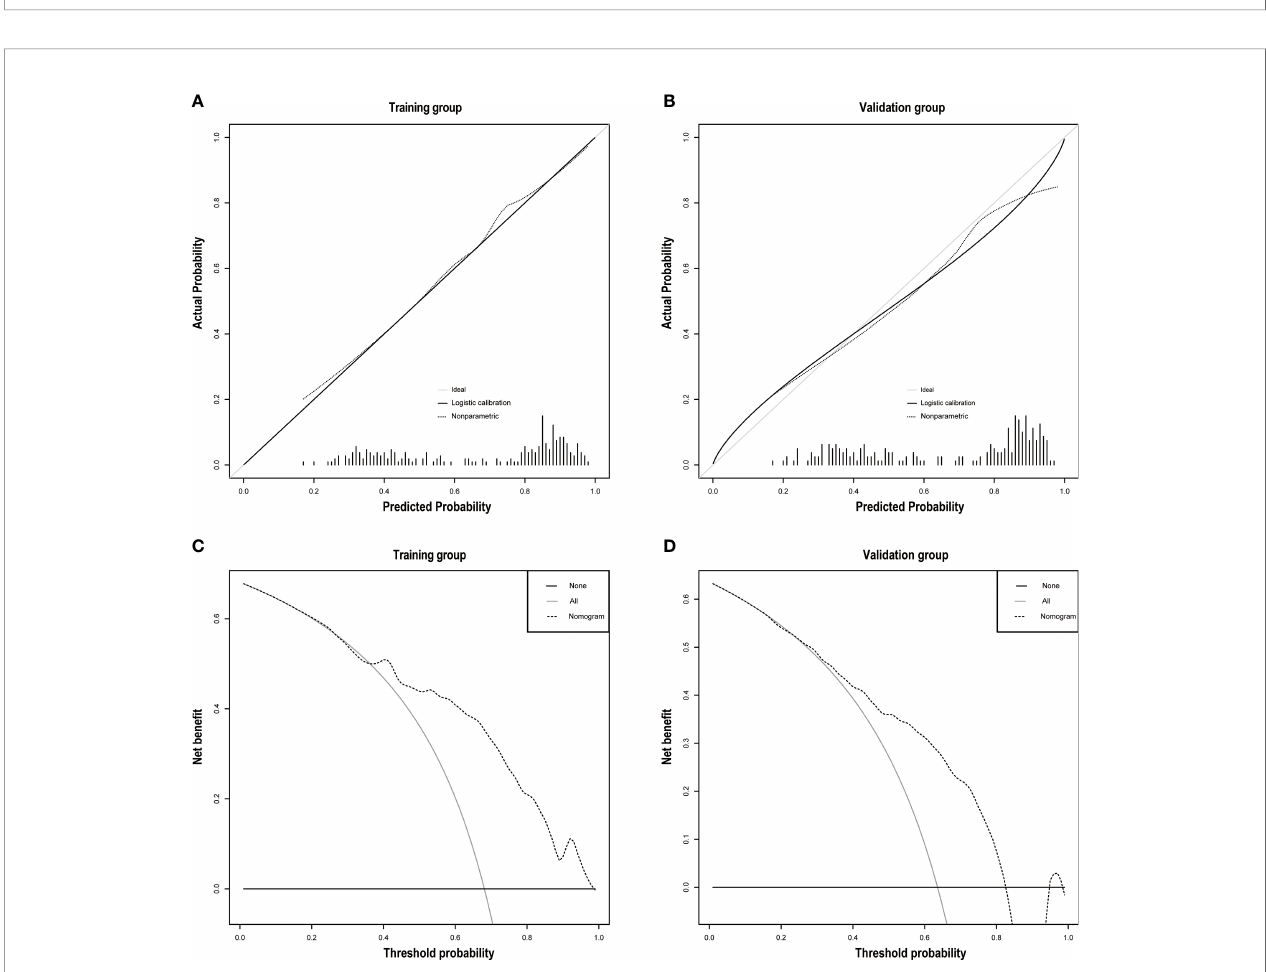
FIGURE 6 | (A) The calibration plots of the training group. (B) The calibration plots of the validation group. Decision curve analyses depict the clinical net bene fi t in the different cohorts. On decision curve analyses, the nomogram showed superior net bene fi t in study cohorts across a range of threshold probabilities. (C) Training group. (D) Validation group.